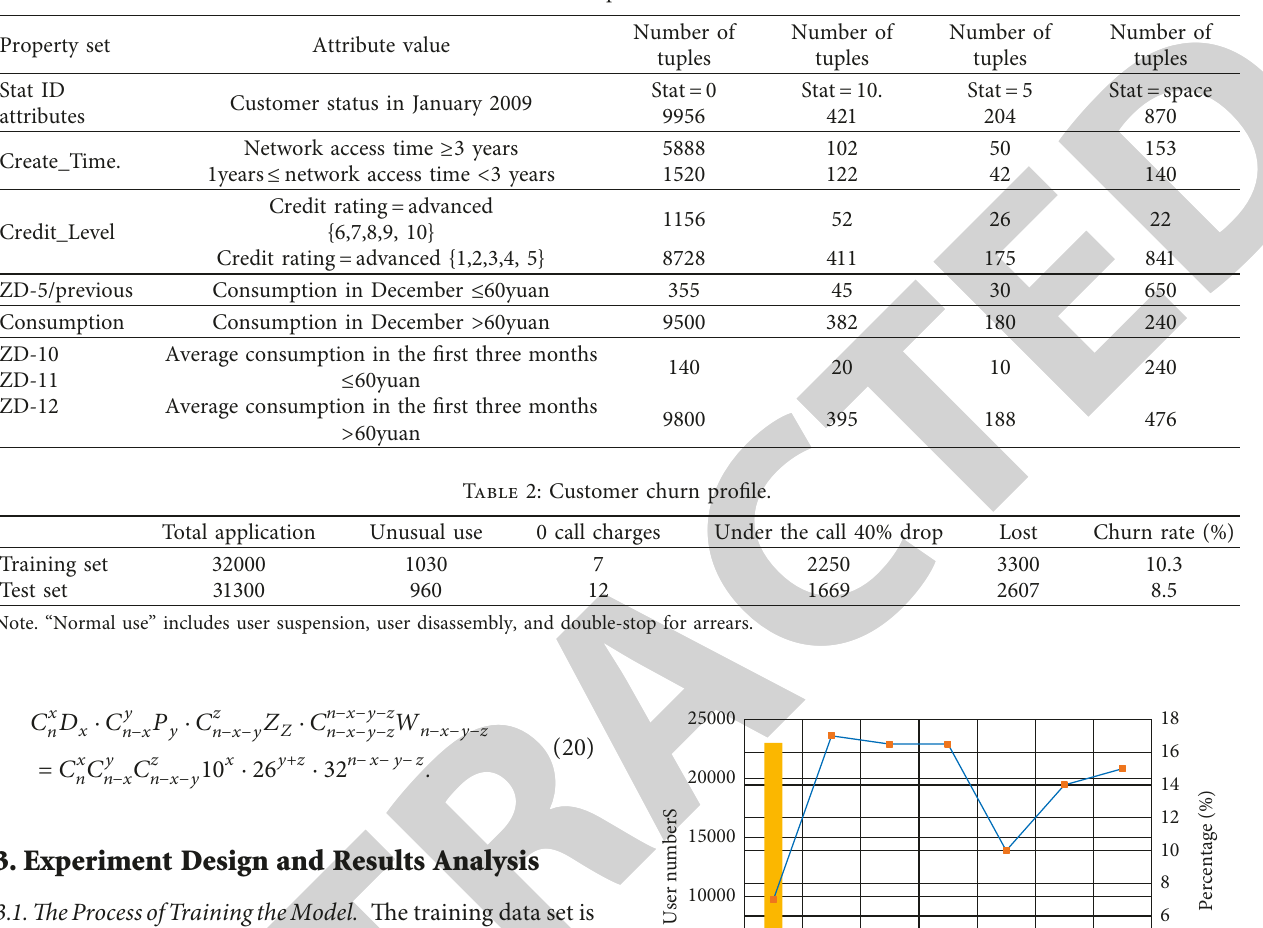
Table 1: Number of set tuples based on user attributes.